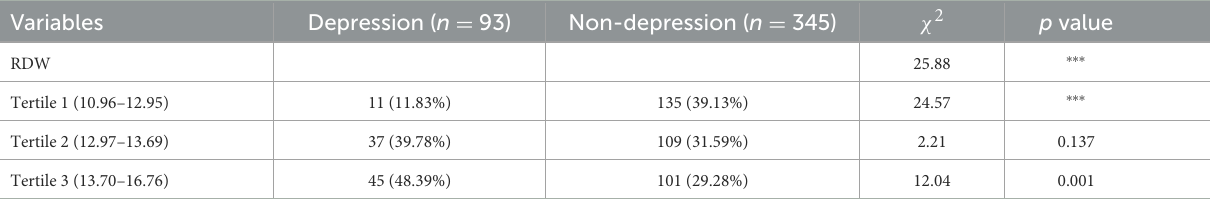
TABLE 3 RDW tertiles of